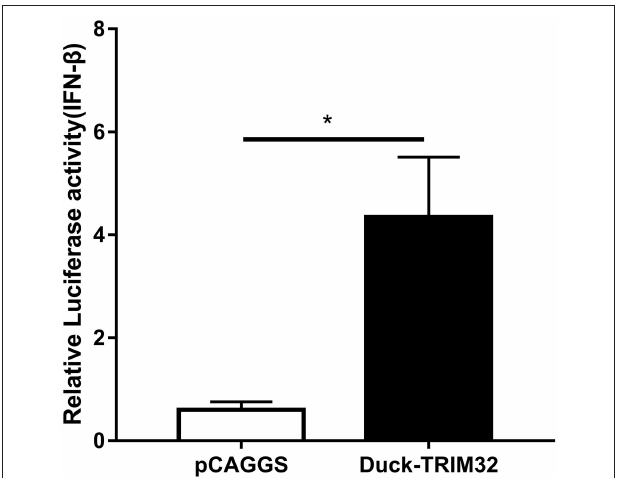
FIGURE 5 | Overexpression of duTRIM32 activates the IFN- β promoter. The DEFs (24 wells) were co-transfected with pGL3-IFN- β -Luc (0.1 µ g/well), PRL-TK plasmids (0.01 µ g/well), pCAGGS-duSTING-HA (0.3 µ g/well), or empty vector (0.3 µ g/well). All data were expressed as means ± SD, the Student’s t -test was used to analyze the differences. (* p <